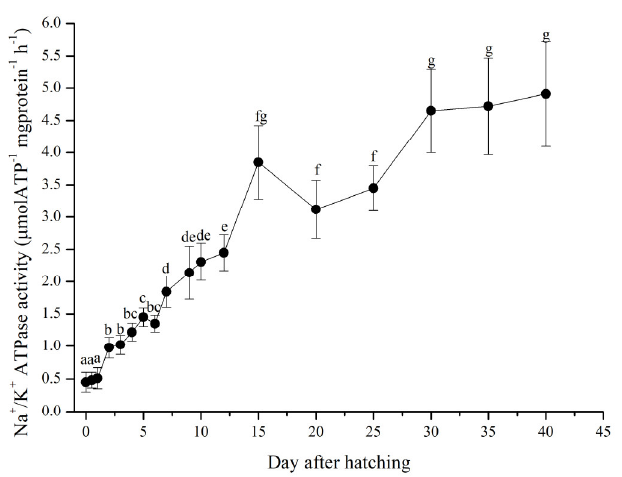
Figure 4. Fluctuations in the specific activities of Na + /K + ATPase in P. dabryanus larvae and juveniles during the experiment. Values in the table are means ± SD, n = 3; different superscript letters indicate significant differences on different days, P < 0.05. From 0 to 20 DAH, whole fish were sampled for Na + /K + ATPase activity test. After 20 DAH, the gills of larvae were sampled directly for Na + /K + ATPase activity test.